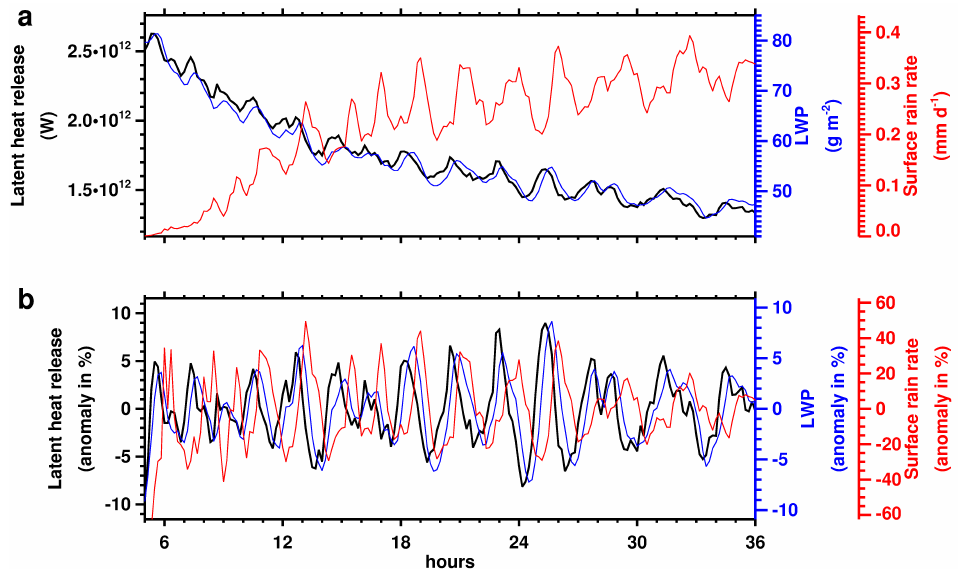
Fig. 6. (a) domain-integrated latent heat release (heating of the air from condensation of water vapor), domain-averaged liquid water path and surface rain, and (b) their temporal anomalies (against a 3h running mean) in simulation S ◦ .